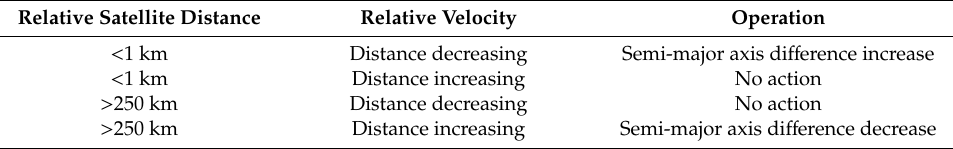
Table 5. Propulsion system operation methodology to maintain nano-satellite